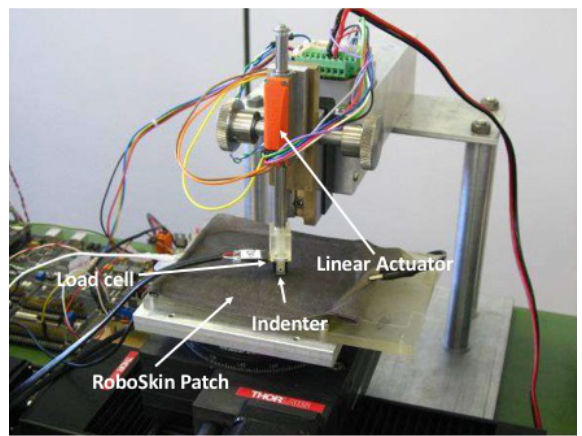
Figure 9. The Setup used for performing the